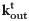
Flowchart schematic illustrating method for manipulating entries of A(1) to satisfy both kin and kout.Once provided a sequence of node degrees in kin and kout, the method classifies which nodes are above (donor), below (recipient) and at (inert) the target koutt, and proceeds to transfer surplus edges from donors to recipients. If enough failures to match suitable edges from the pool of donors to recipients occur, shuffling of edges from the set of inert nodes is performed. The process continues until deviation from koutt falls below acceptable tolerance, ϵ, and we obtain a final adjacency matrix A(f).